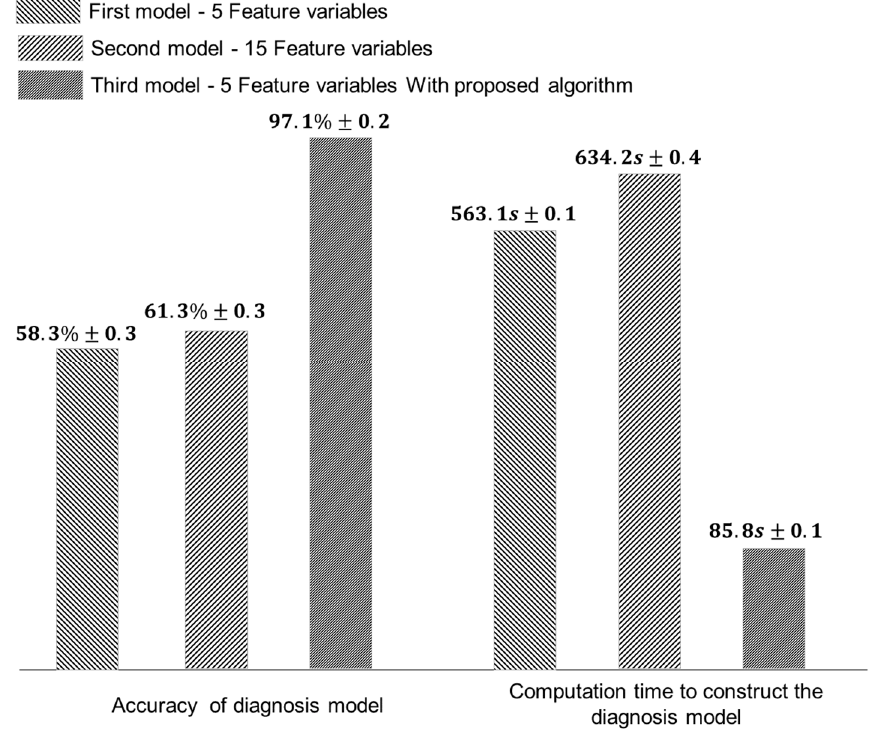
Figure 9. Accuracy and computation time of diagnosis models for AI7075.